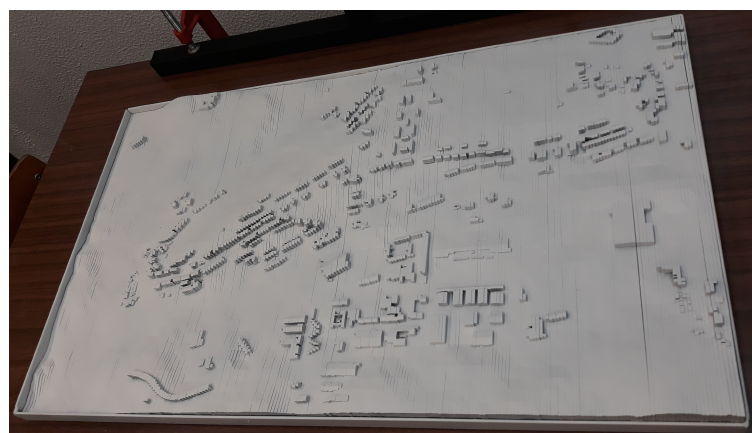
Figure 5. Physical model, framed and painted.